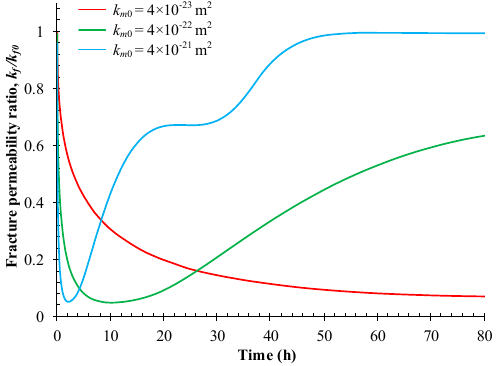
Figure 21. Evolution of fracture average permeability ratio at different initial matrix permeabilities.